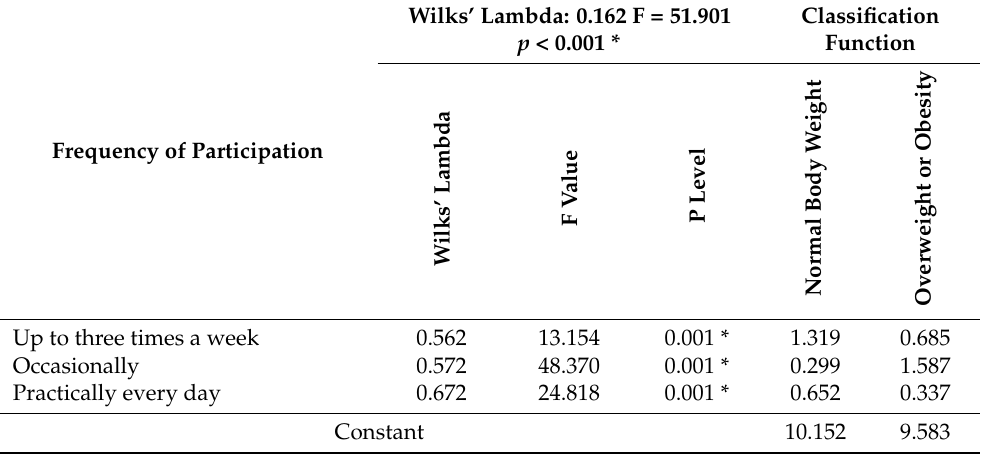
Table 3. Frequency of participation in NW